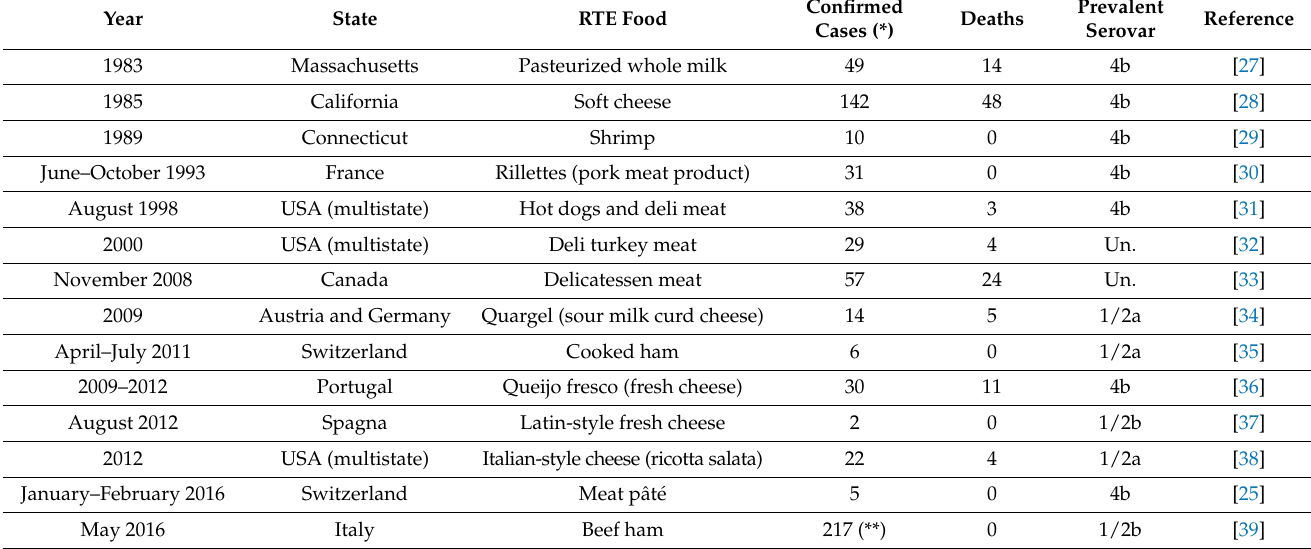
Table 2. Some foodborne disease outbreaks of listeriosis registered around the world caused by the consumption of ready-to-eat (RTE)